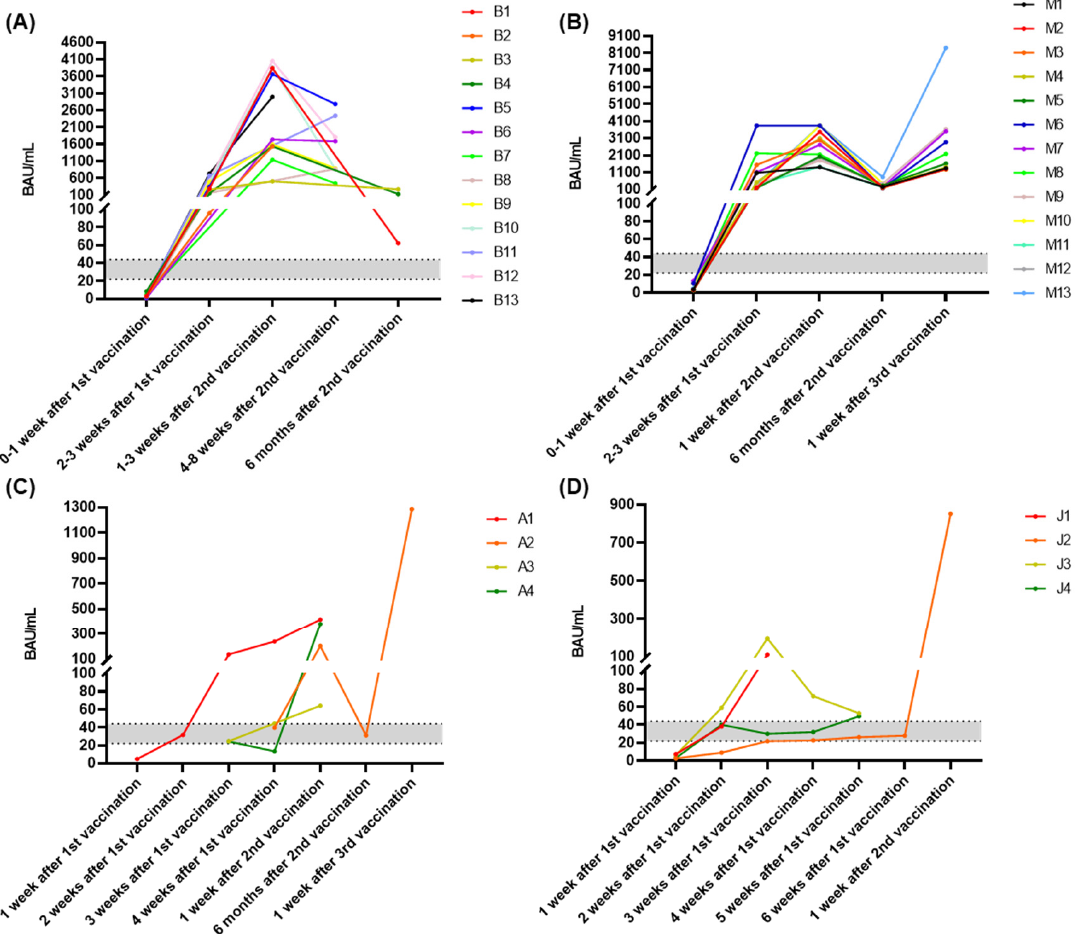
Figure 4. Time course of antibody titers (BAU/mL) determined following four different types of COVID-19 vaccination. Serum or DBS samples collected from donors vaccinated with ( A ) Pfizer- BioNTech ( n = 13), ( B ) Moderna ( n = 13), ( C ) AstraZeneca ( n = 4), and ( D ) Johnson & Johnson ( n = 4) vaccines. Blood samples were collected from five to seven time points for each vaccine before or after vaccination. Results were converted to binding antibody units (BAU/mL) using the absorbances recorded at 450 nm of six calibrators. The cutoff was 22 BAU/mL for the in-house ELISA. The grey zone above the cutoff (22–44 BAU/mL) indicates a borderline range.